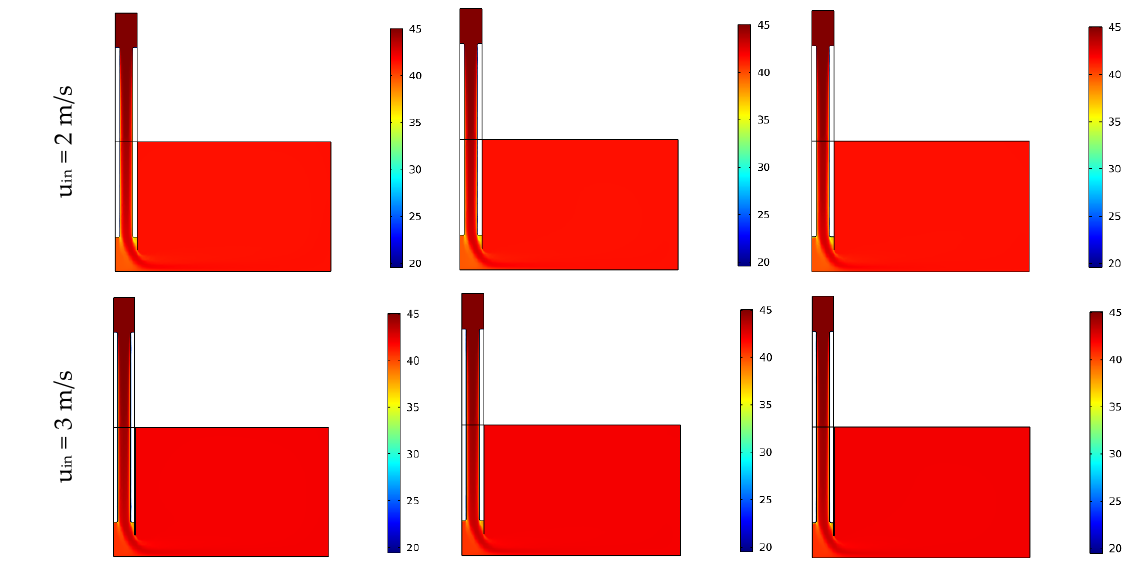
Figure 4. Effect of inlet velocity of the temperature field; T in = 45 °C, and t = 1000 s. This is confirmed by Figure 5, which illustrates the temporal evolution of the temper- ature field for a tower inlet velocity of 0.5 m/s. The figure shows the development of a thermal boundary layer inside the tower along the porous medium. First, just after 10 s, the chamber floor was subjected to a temperature drop, and then the cold air layers extended along the right vertical wall and over the roof. After 240 s, the steady state was almost reached, and the chamber temperature became almost uniform. Even lower temperatures of 35 ◦ C were detected at the tower’s base in the dead zone.